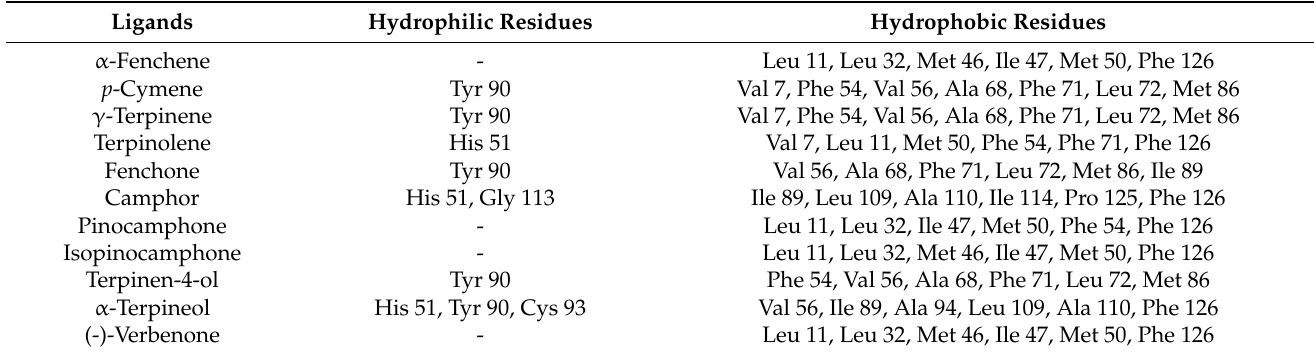
Table 4. The key residues of DhelOBP4 interacted with HIPVs within 4